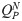
The rate κ of perturbation of initial system states contributes to the increase in modularity due to selection for two GAPs.The increase in modularity after selection for two target GAPs is greater when evolution occurs under higher rates of non-genetic perturbation. The selection regimes are the same as in Fig 3. In a first stage, selection favoured networks that produced target GAP I. In a second stage, networks with highest fitness were those that produced GAPs I and II from different initial system states (Fig 3A). QPN refers to a partition P that assigns the first five genes to one set and the rest of the genes to another.